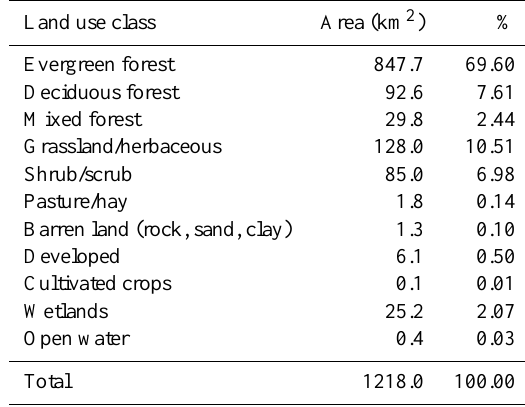
Table 1. Land use classification of the JRB area. 79.7% of the total basin is covered by forest, according to the National Land